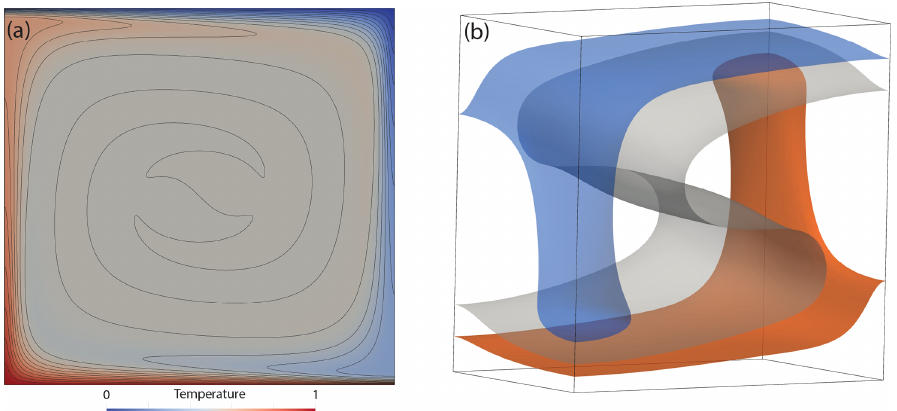
Figure 2. Final steady-state temperature field, in 2-D and 3-D, from Firedrake simulations, designed to match: (a) Case 1a from Blankenbach et al. (1989), with contours spanning temperatures of 0 to 1 at 0.05 intervals. (b) Case 1a is from Busse et al. (1994), with transparent isosurfaces plotted at T = 0 . 3, 0 . 5 and 0 .